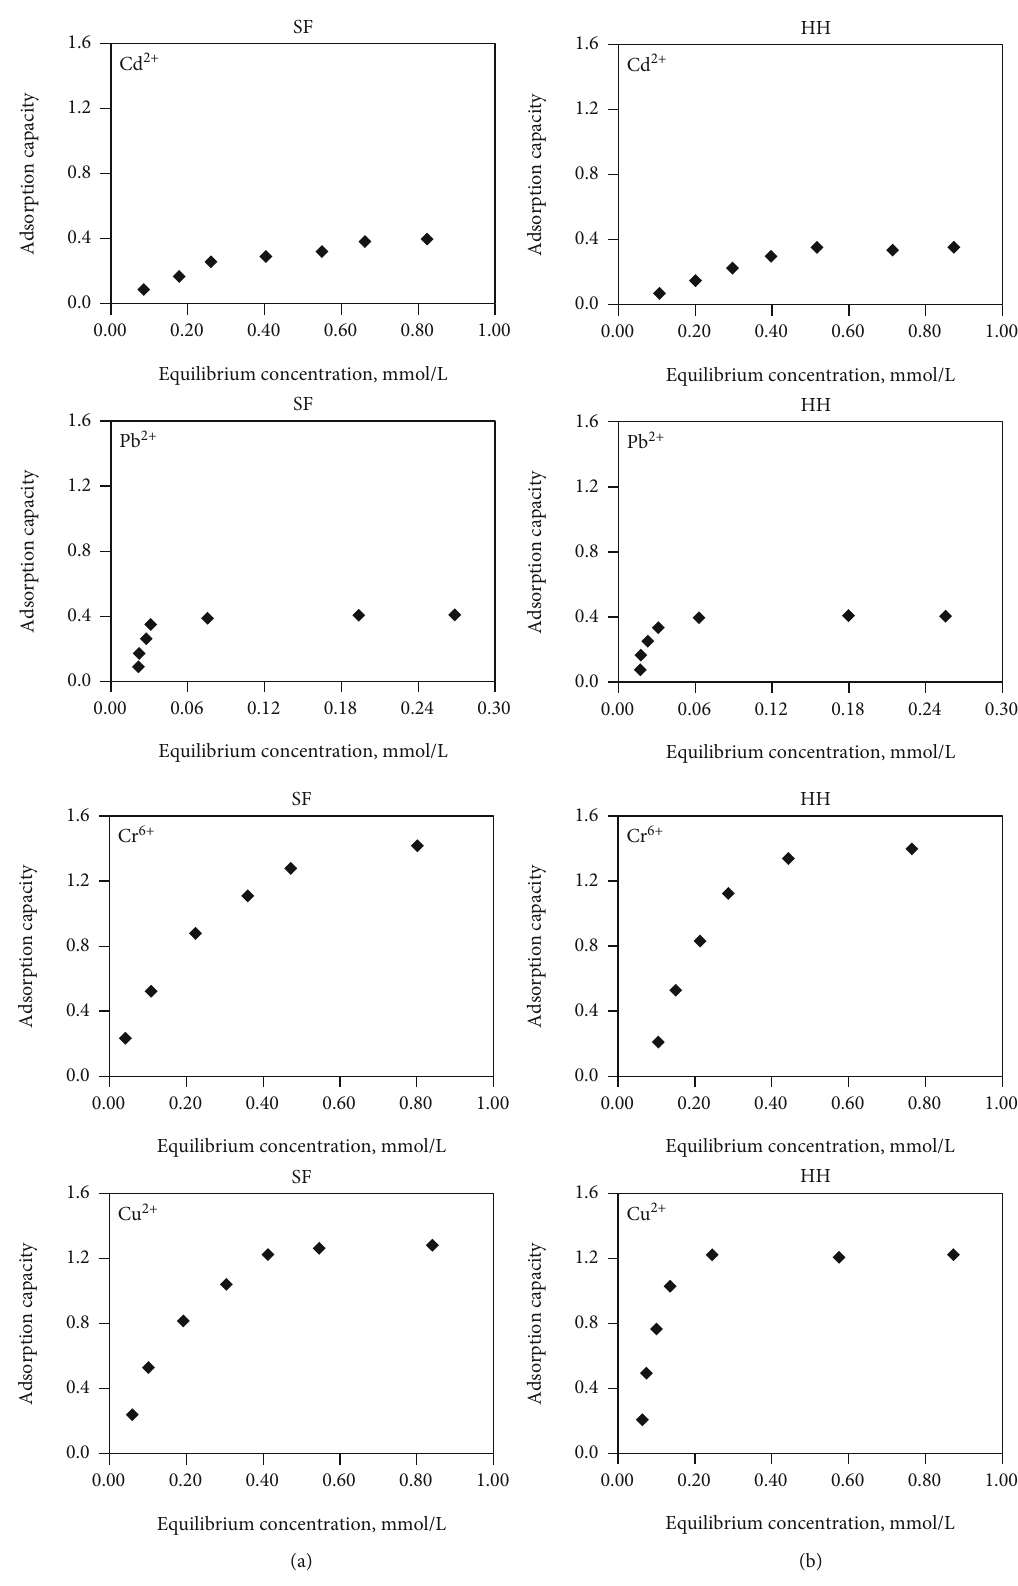
Figure 6: Isotherms of the adsorption of heavy metal ions from aqueous solutions using (a) SF and (b) HH at pH 4 and